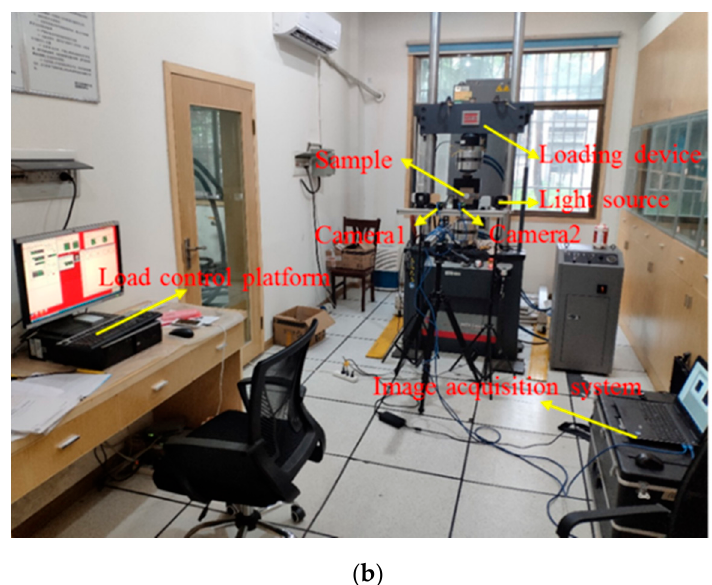
Figure 2. ( a ) A typical speckled pattern of specimen WS3-1; and ( b ) experimental setup for the Brazilian test.